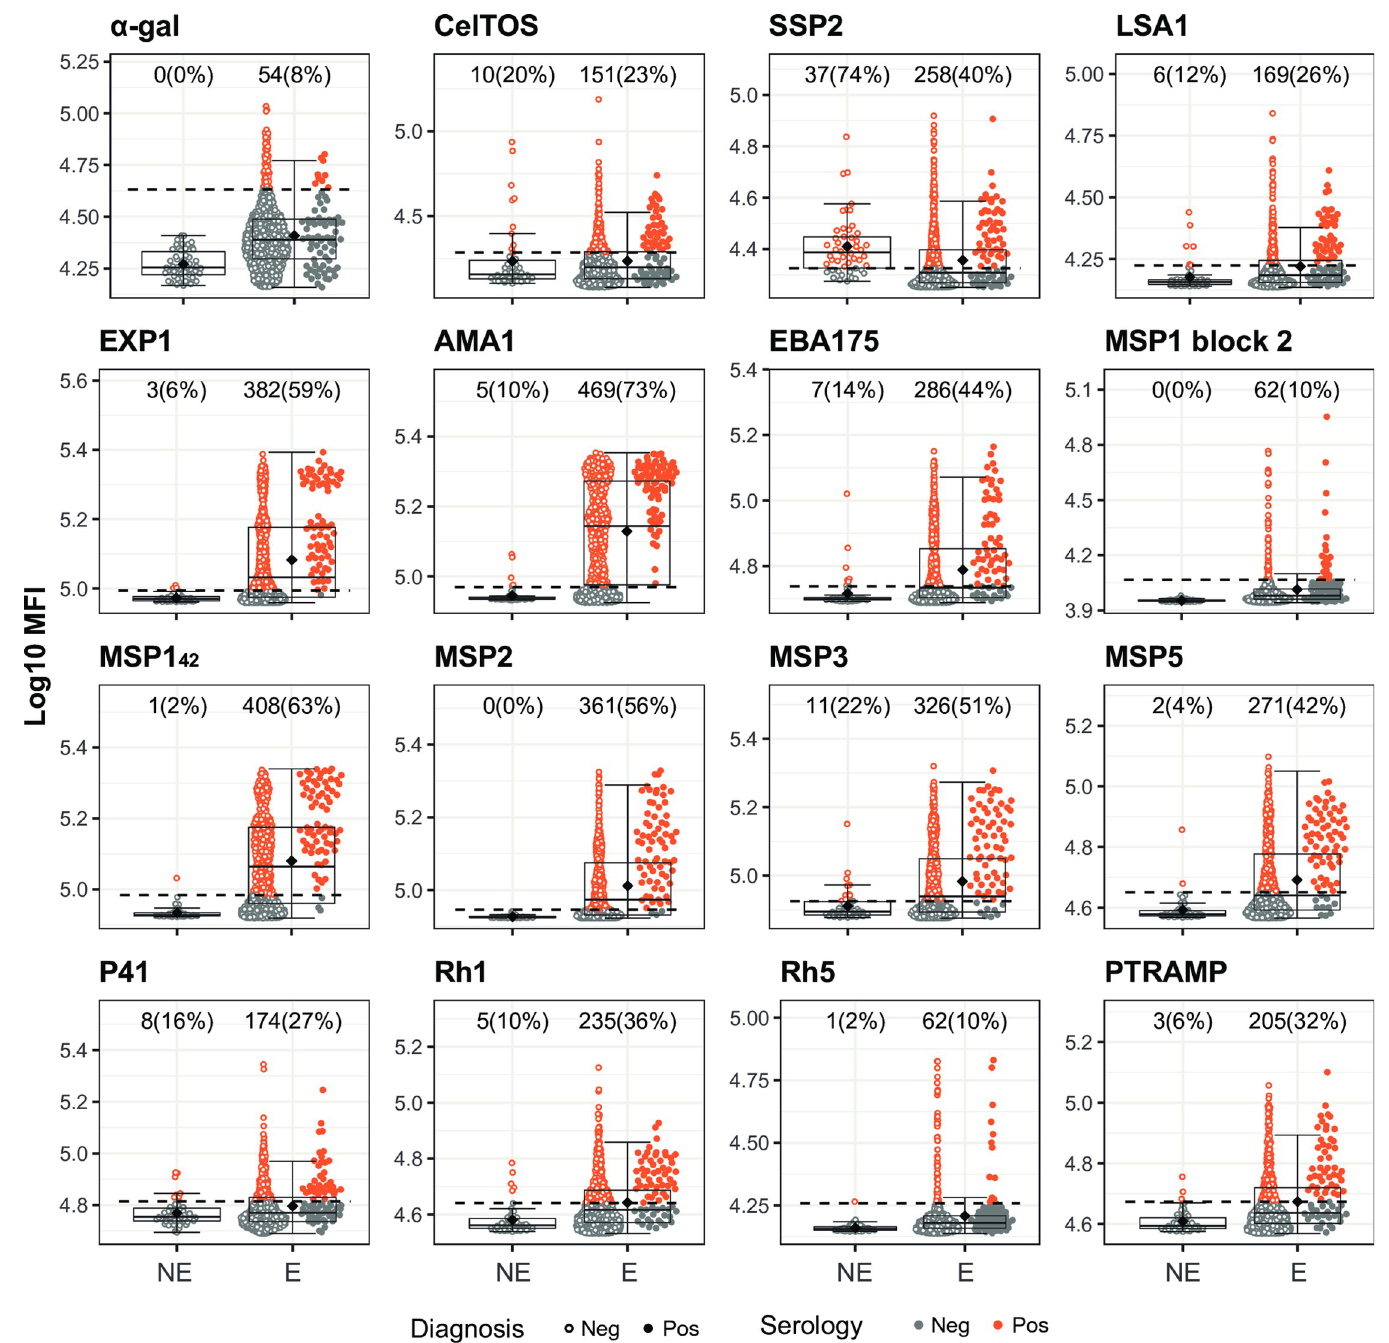
Fig 10. Plasmodium falciparum antigen-specific IgG levels in non-endemic and endemic populations and seropositivity cutoffs by the Expectation-Maximization algorithm. Antibody levels are presented as the log 10 -transformed median fluorescence intensity (MFI) of IgG against P . falciparum antigens. In the endemic population, filled dots highlight individuals with a P . falciparum infection detected by qPCR. The dashed line represents the serology cutoff calculated with the Expectation- Maximization algorithm. Individuals above (orange) or below (grey) this cutoff were considered seropositive or seronegative, respectively. At the top of each plot, the absolute number and percentage of seropositive individuals with respect to the Non-Endemic (NE) (N = 50) or Endemic (E) (N = 715) populations are indicated. The boxplots represent the median (bold line), the mean (black diamond), the first and third quartiles (box) and the largest and smallest values within 1.5 times the interquartile range (whiskers). Data beyond the end of the whiskers are outliers.